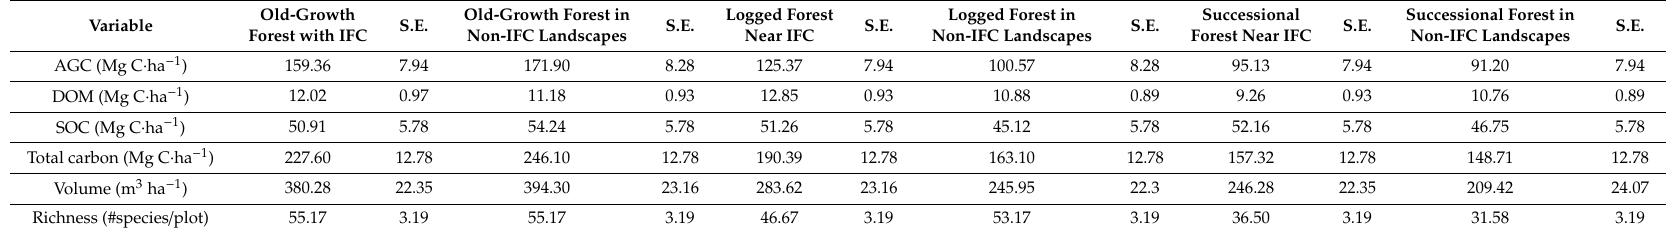
Table A7. Mean values and standard error for AGC, DOM, SOC, total carbon, timber volume and species richness for IFC, non-IFC and forest types. Old-Growth Variable Forest with